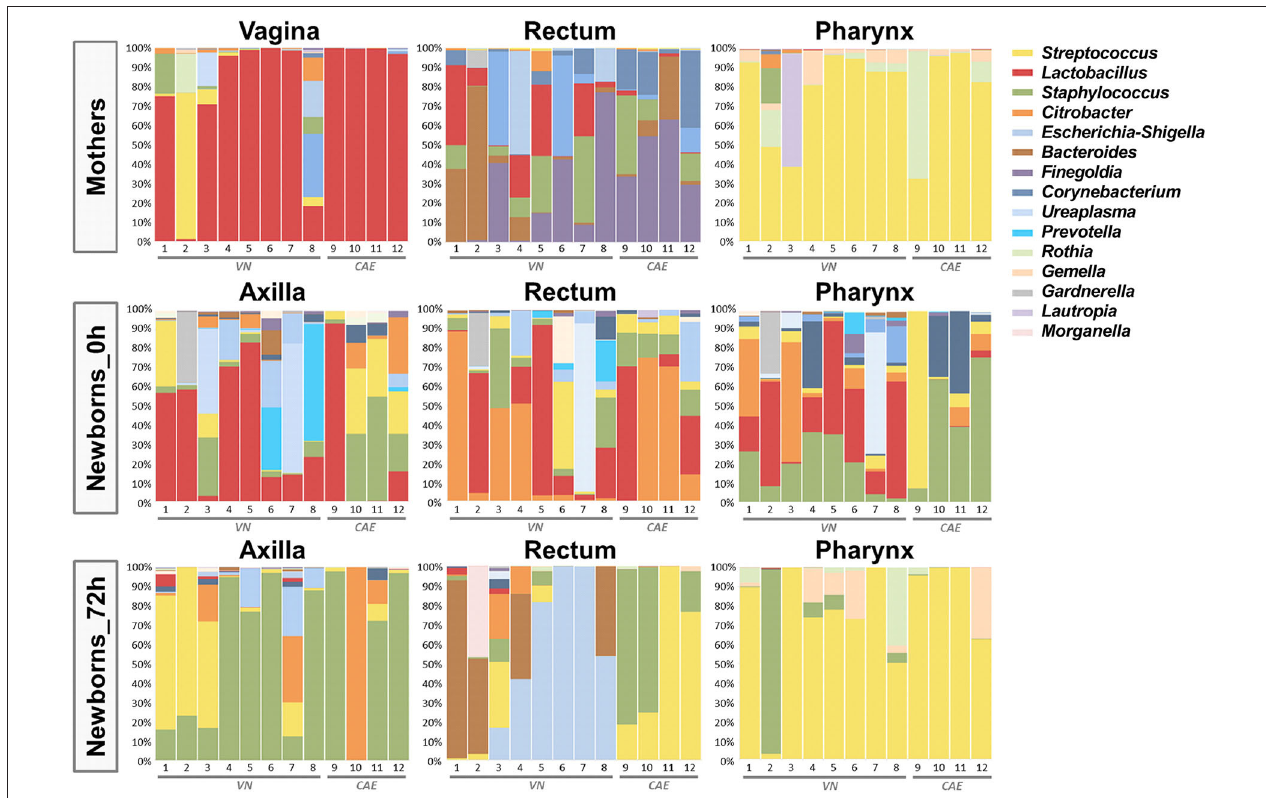
FIGURE 1 | Taxonomic summary depicting the distribution of the microbiome of the 12 mother-child pairs. Bar charts show the relative microbial distribution at genus level for all different analyzed body sites (VN, via naturalis ; CAE, cesarean section ).